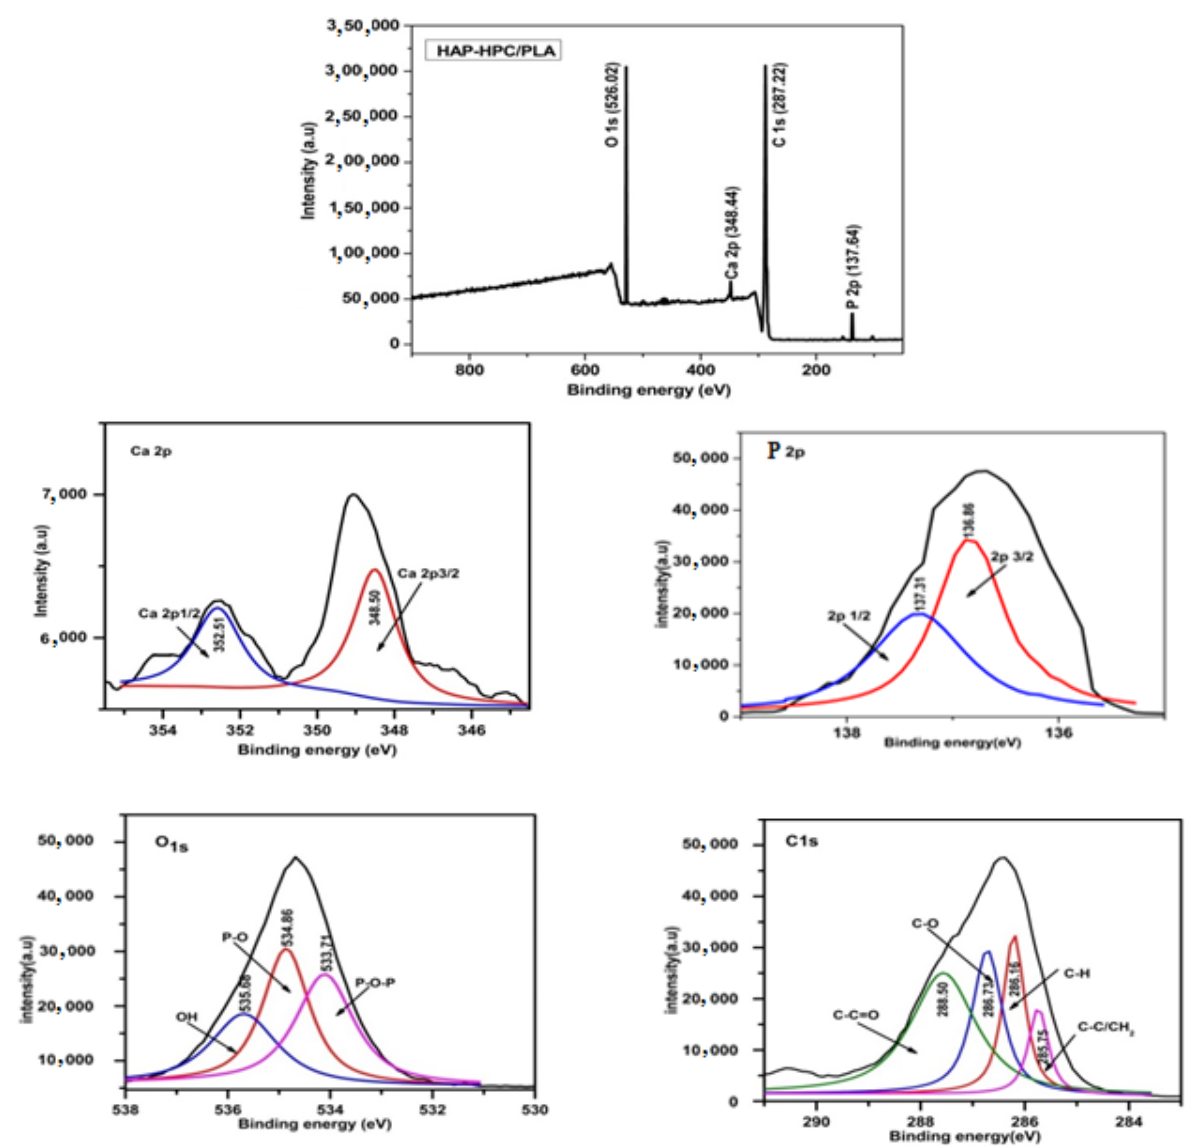
Figure 4. The XPS full survey for HAP-HPC/PLA nanofiber and core level spectrum of Ca 2p, P 2p, O 1s, and C1s